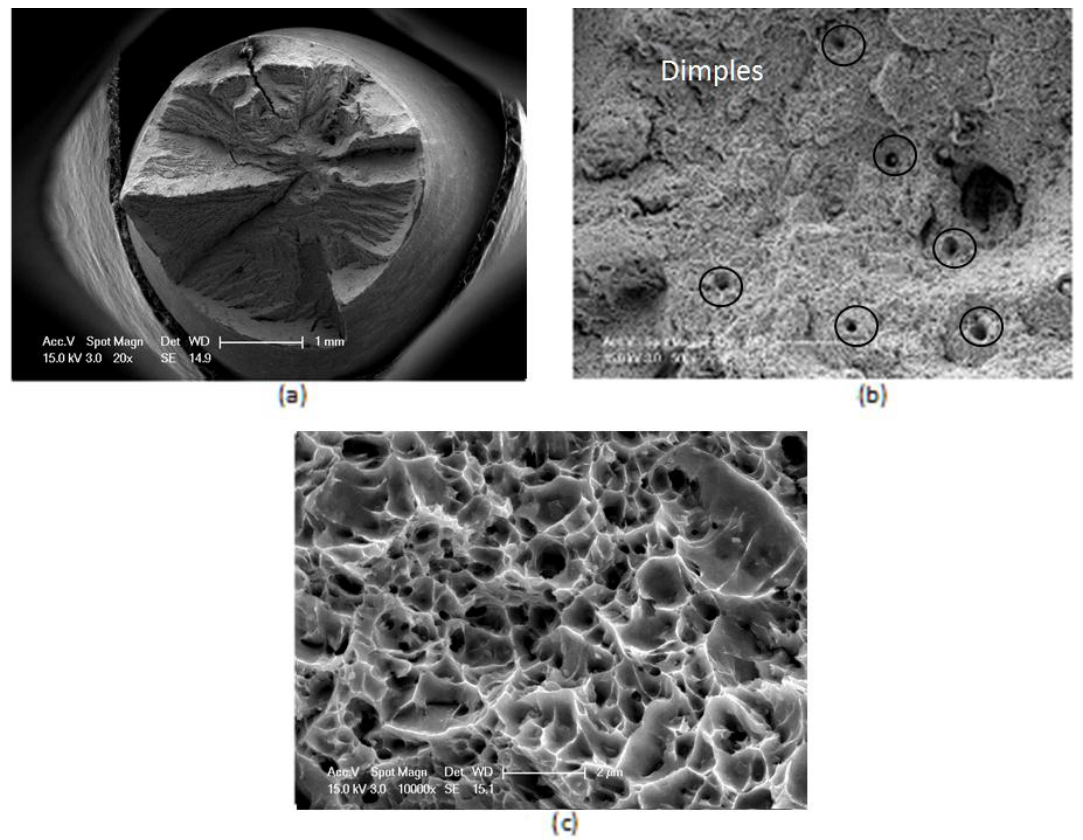
Figure 12. Fractography of the dissimilar metal weld at the 12Cr steel side: ( a ) at 1 mm resolution; ( b ) at 50 µm resolution; ( c ) at 2 µm resolution.